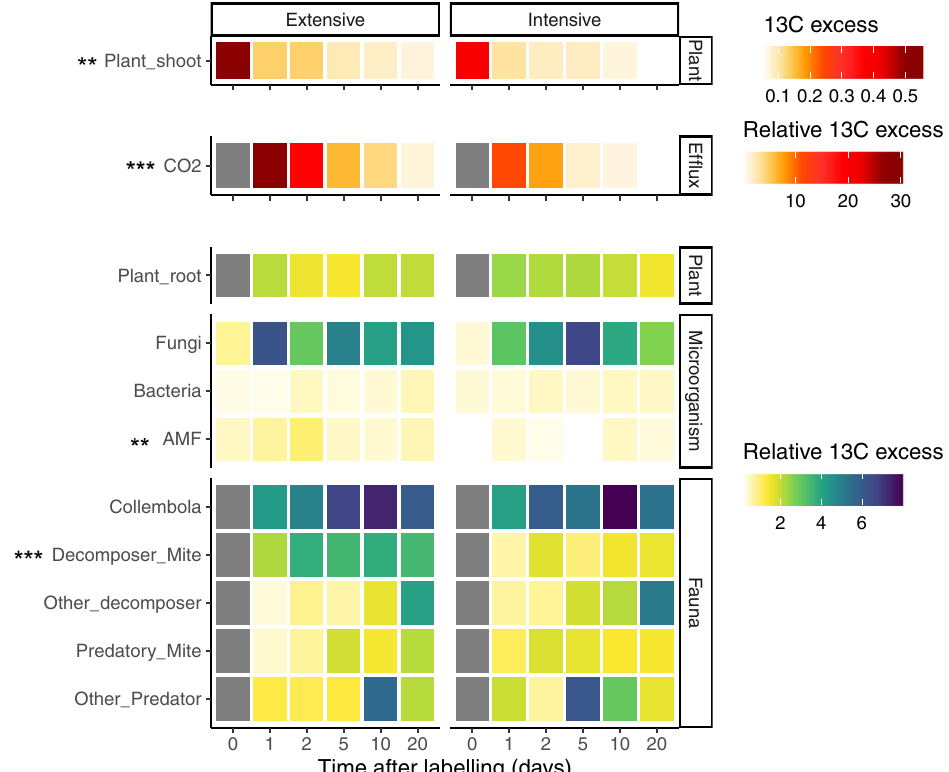
Fig. 4 | Management impact on the 13 C transfer in the plant-soil system. Tem- poral dynamics of 13 C in the plant shoot (upper panel), soil CO 2 ef fl ux (middle panel) and below-ground pools (lowerpanel)following 13 C pulse labelling (time 0) from the control plots ( n =108). The heat map shows the 13 C-enrichment in dif- ferent pools and fl uxes in grassland under extensive (left) or intensive (right) management.Theplantshootenrichmentisexpressedinatom%excess;however, to be able to compare the fl ux of C from the plant to below-ground, all the other